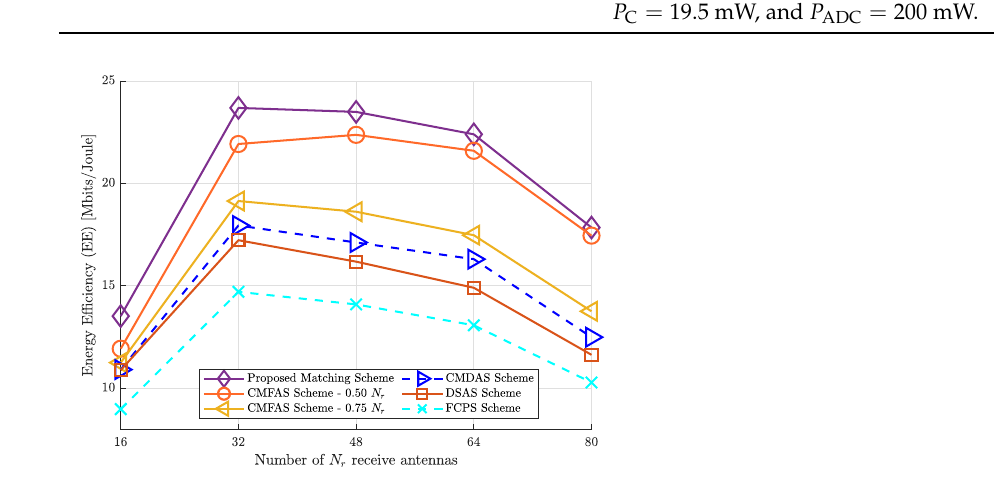
Figure 3. EE versus number N r of antennas, where M = 80 APs, N Q = 8, ρ = 23 dBm, and K = 8